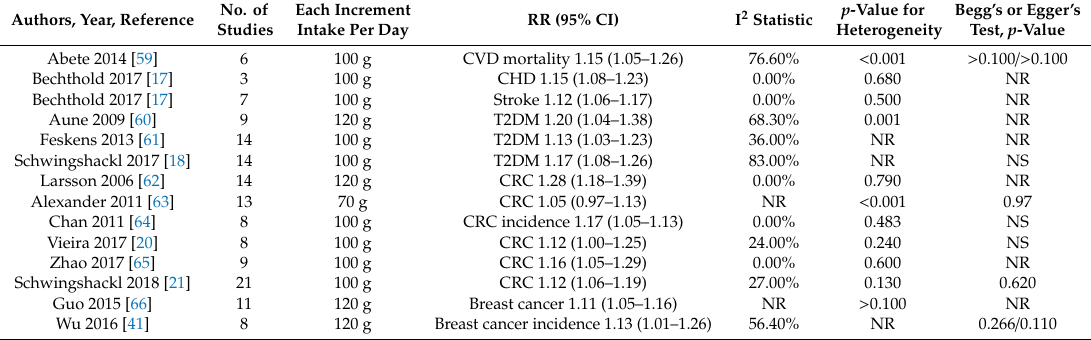
Table 14. Summary of linear dose-response meta-analyses of prospective studies on red meat intake and CVD, CHD, stroke, T2DM, CRC, breast